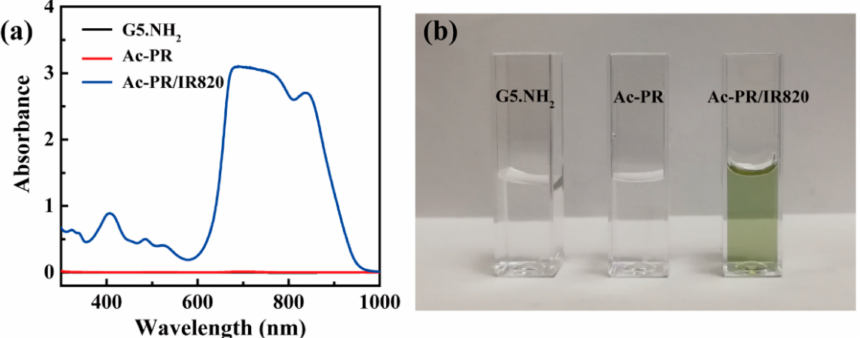
Figure 3. UV-vis spectra of G5.NH 2 , Ac-PR, and Ac-PR/IR820 dendrimers ( a ) and their corresponding photos ( b